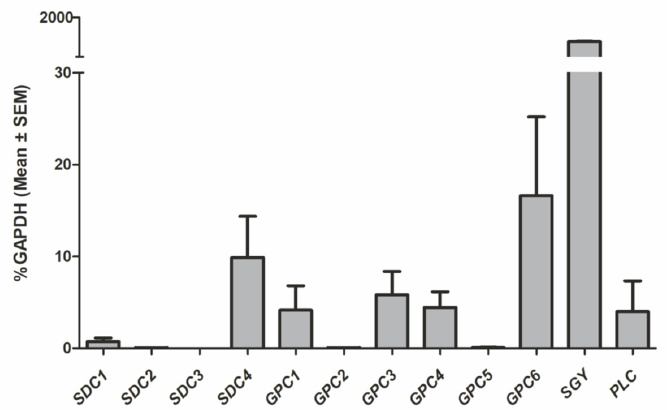
Figure 6. Gene expression profile of syndecans ( SDC1-4 ), glypicans ( GPC1-6 ), and perlecan ( PLC ) in eosinophils in comparison to housekeeping gene GAPDH RNA expression (set as 100%); elevated levels were determined for SDC4 , GPC1 , 3 , 4 , 6 , serglycin , and perlecan ; mean CT used in the analysis of relative gene expression